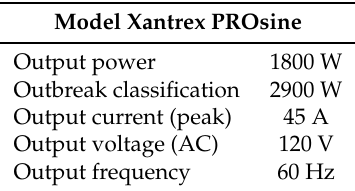
Table 2. Technical specifications of the Xantrex PROsine 1800 W inverter.